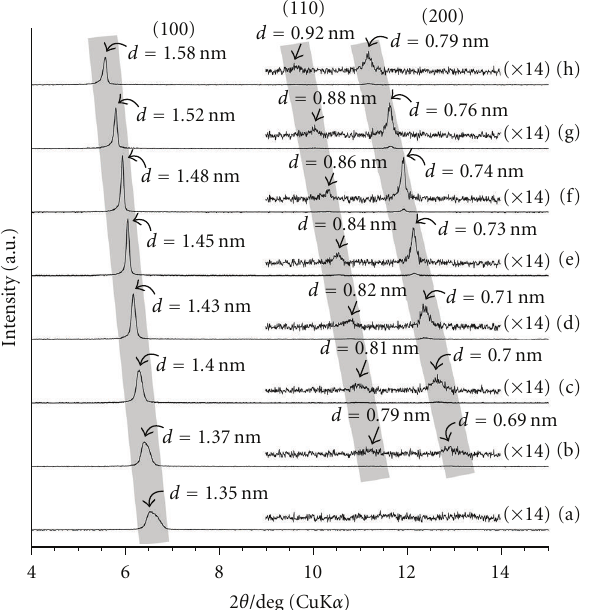
Figure 2: XRD patterns of PSQ-NH 3+ Cl − under various RH conditions: (a) 20, (b) 30, (c) 40, (d) 50, (e) 60, (f) 70, (g) 80, and (h) 90% RH. Amount of each product on glass was ca . 2.0mg/cm 2 .